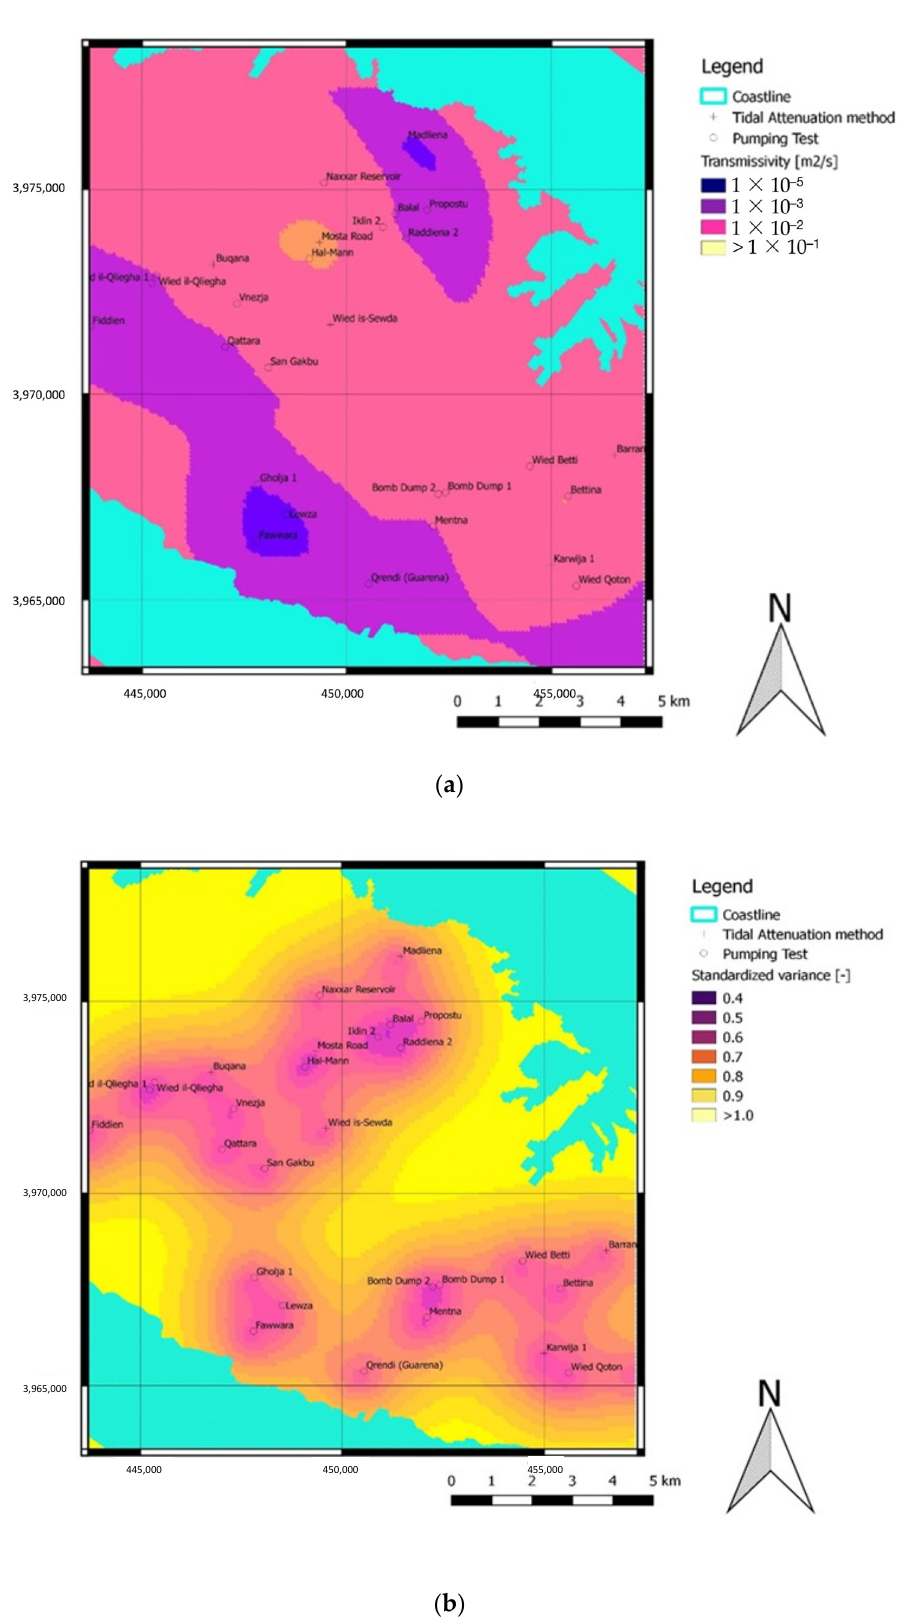
Figure 11. Map with the spatial distribution of the transmissivity of the Malta MSLA obtained by ordinary kriging interpolation ( a ) and the corresponding error map showing the spatial distribution of the estimated kriging variance divided by sample variance ( b ).